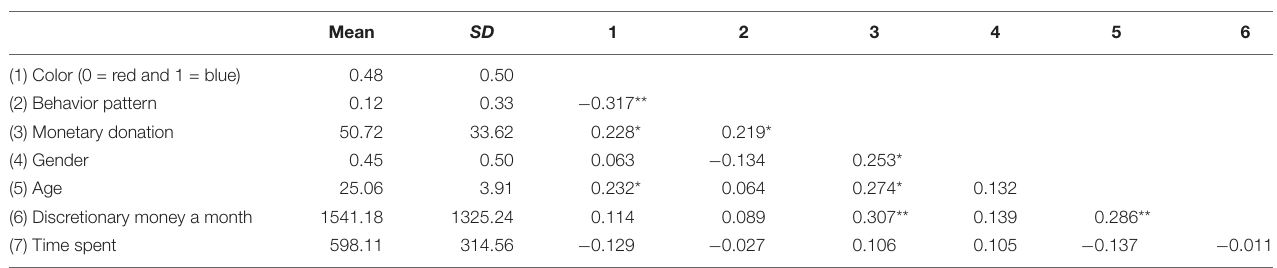
TABLE 1 | Means, SD, and correlations of all variables in monetary donation